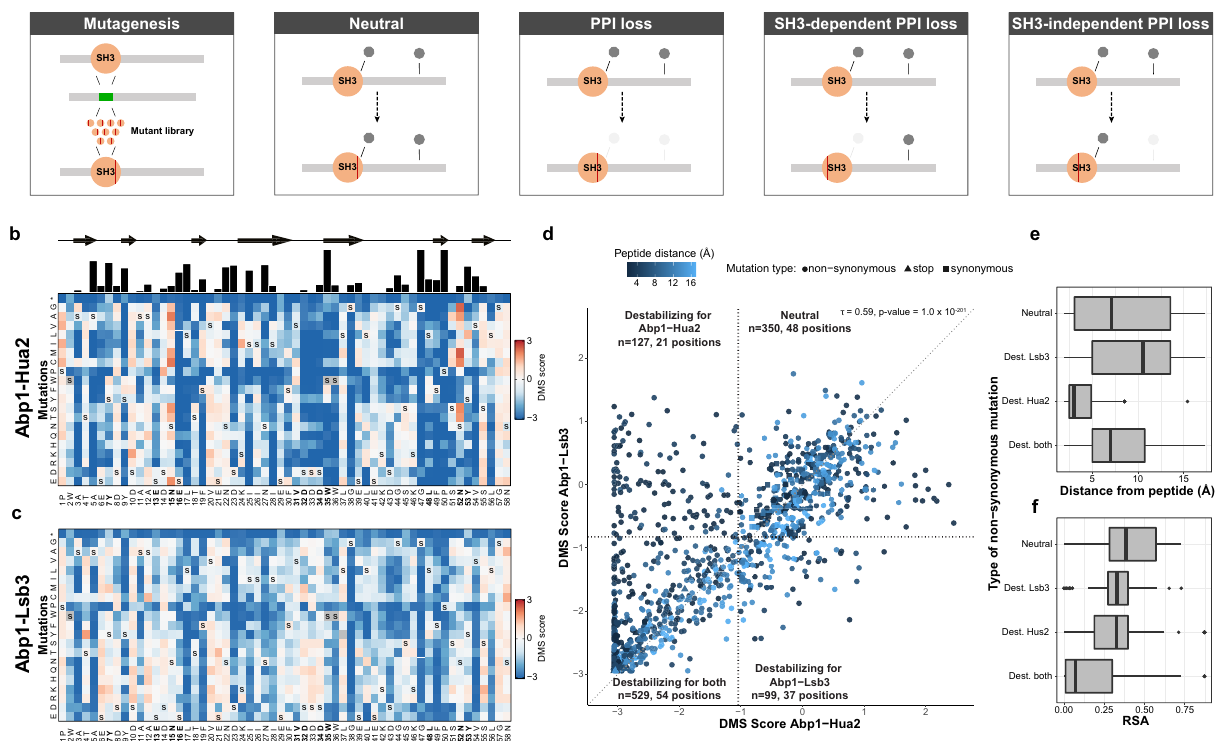
Fig. 3 SH3 domain sequences affect both SH3-dependent and -independent PPIs. a The stuffer DNA of an SH3-deleted strain is replaced by a library of single mutants. Categories of mutations based on their effect on PPI types are shown. b , c Impact of mutations on binding represented in terms of deep mutational scanning (DMS) score. b Tolerance to SH3 mutations of the SH3-dependent interaction Abp1-Hua2. Blue: low DMS score, i.e., reduced interaction strength, red: increased strength. The secondary structure of the SH3 is shown above. The black bars on the top represent the level of conservation across the 27 S. cerevisiae SH3s. Positions in bold represent residues in contact with the ligand (see also Supplementary Fig. 3H). c Same as panel b , but for the SH3-independent Abp1-Lsb3 PPI. The data shows the average of two biological replicates. d DMS scores for the two PPIs. DMS scores below the fi rst percentile of the synonymous variant (dashed line) are de fi ned as destabilizing the PPI. Four categories of mutants are shown: (1) destabilizing both PPIs, (2) speci fi cally destabilizing Hua2 PPI or (3) Lsb3 PPI, and (4) neutral or slightly increasing binding. The minimum distance relative to a binding peptide is shown in blue (Ark1 peptide 24 ). e Minimum distance to the Abp1-bound peptide and ( f ) the relative solvent accessibility (RSA) for each category. Dest is for destabilizing mutations. For e , f , n = 349 neutral amino acid mutations, n = 98 amino acid mutations that destabilize Lsb3 only, n = 126 amino acid mutations that destabilize Hua2 only, n = 528 amino acid mutations that destabilize both Lsb3 and Hua2. For the boxplots, the median is represented as a bold center line and hinges are for the 25th and 75th percentiles ( fi rst and third quartiles). Whiskers extend from the hinges